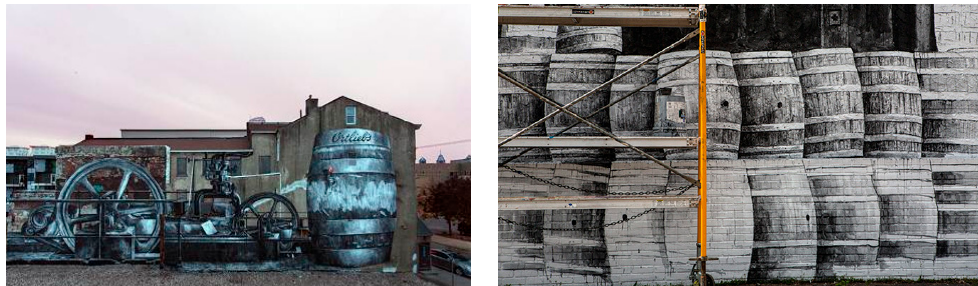
Figure 2. Two of the murals made by Phillip Adams in